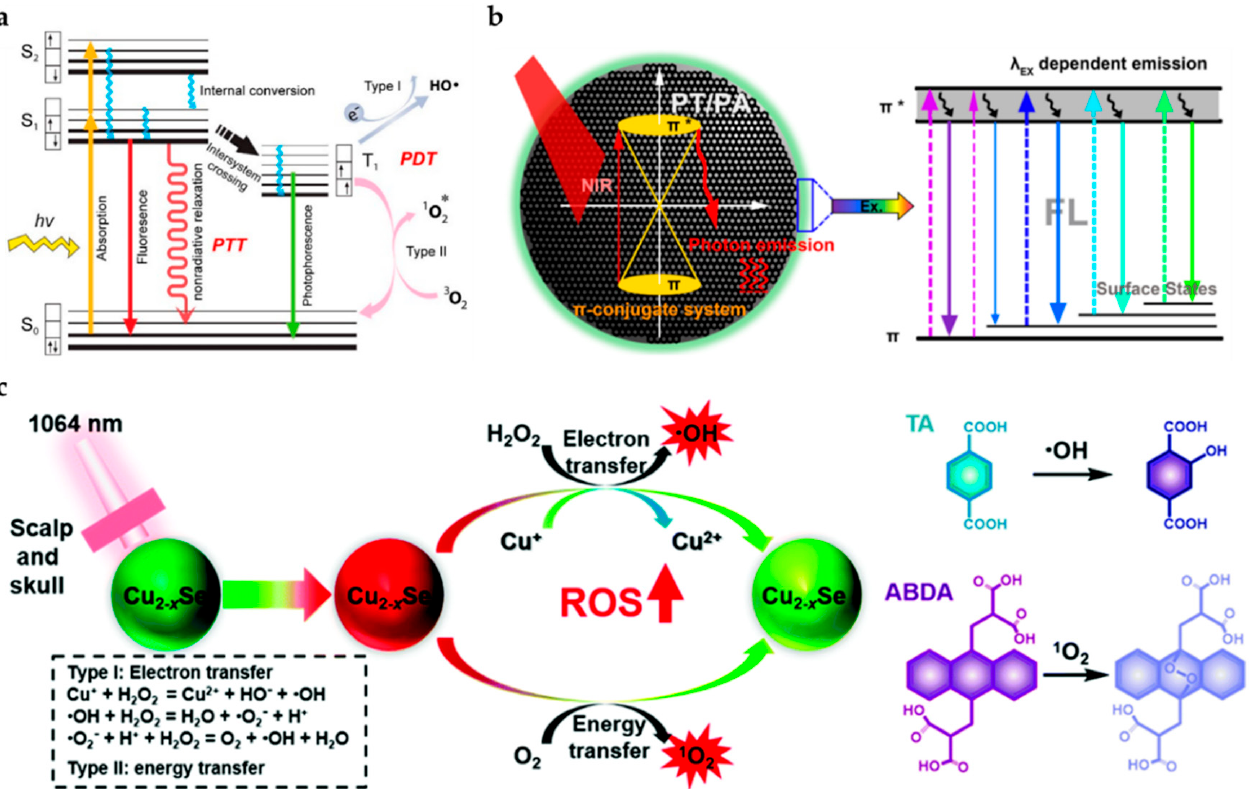
Figure 5. The common nanoprobes in glioblastoma imaging. ( a ) The common pathways of photothermal and photodynamic therapy [85]. The * symbols next to the atomic or atomic group indicates that there are no paired electrons. ( b ) The mechanism of carbon nanodot with simultaneous laser irradiation to induce photothermal effect and fluorescence [89]. ( c ) The two ROS generated ultrasmall Cu 2 − x Se quantum dots by electron transfer and energy transfer [83]. Adapted with permission from Refs. [83,85,89]. Copyright 2009 Royal Society of Chemistry, 2018 and 2020 American Chemical Society.